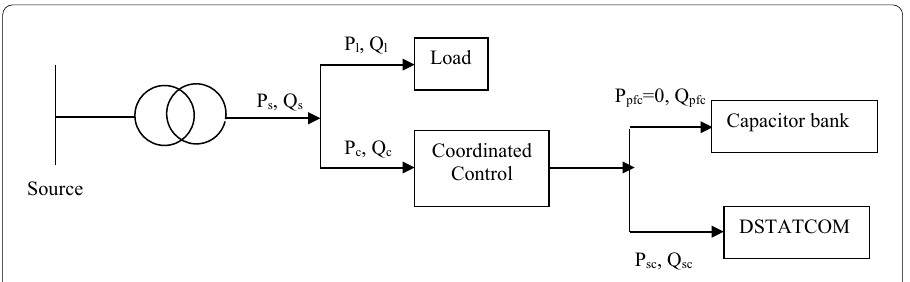
Fig. 10 Active and reactive power flow in a coordinated